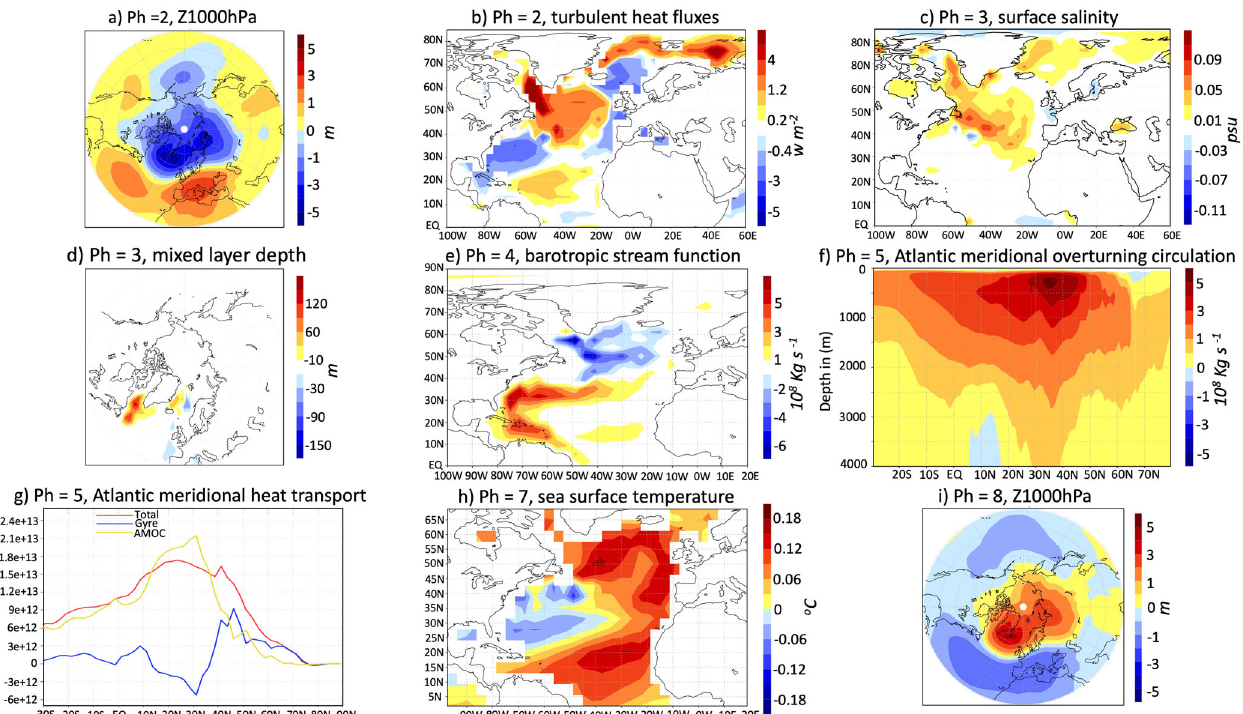
Fig. 4 Dynamics of the damped coupled stratosphere/troposphere/ocean oscillation. a , b The MSSA-reconstructed 1000 hPa geopotential height (in m ) and upward oceanic turbulent heat- fl uxes (in w m − 2 ) respectively at phase 2. c , d Surface salinity (in psu) and mixed-layer depth (in m) during phase 3, respectively. e Ocean barotropic mass stream function during phase 4 (in 10 8 Kg s − 1 ). f Latitude-depth section of the ocean meridional overturning mass stream function in the Atlantic Ocean (north of 30° S) during phase 5 (in 10 8 Kg s − 1 ). g The zonally averaged poleward Atlantic heat transport in W (during the phase 5) by the total oceanic circulation (red), the AMOC (yellow) and the oceanic gyre (blue). h The reconstructed SST anomalies at phase 7 (in °C), i the reconstructed 1000 hPa geopotential heights at phase 8 (in